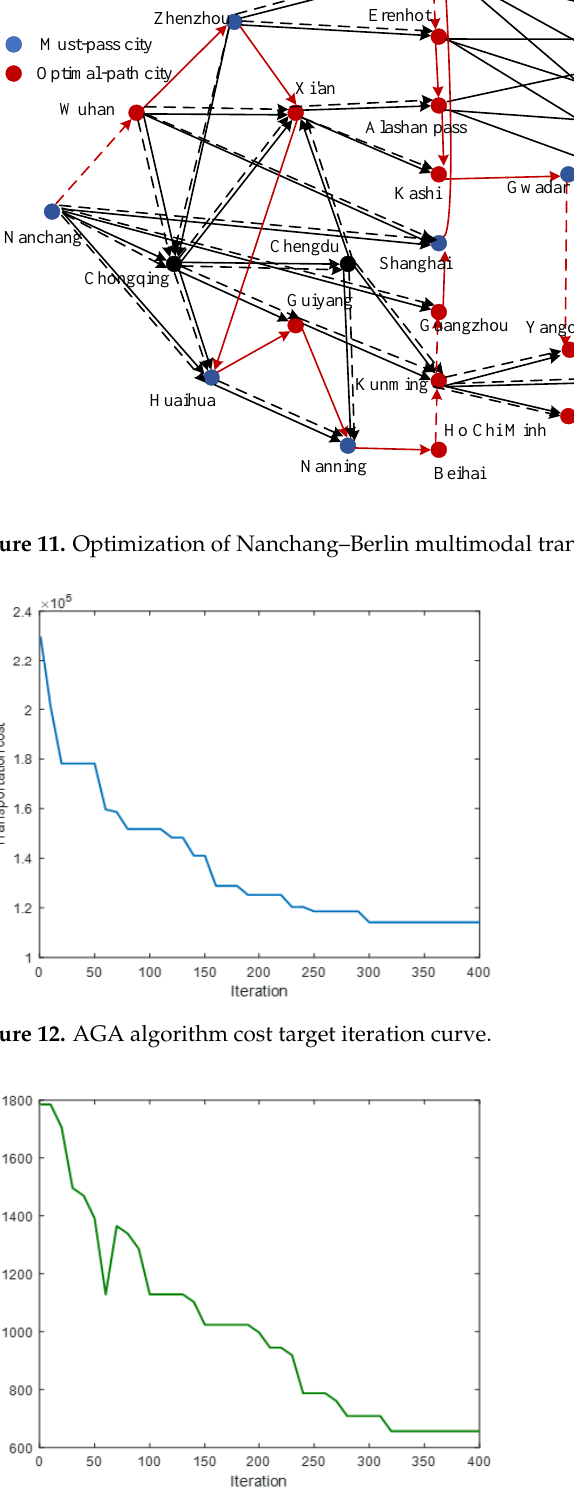
Figure 13. AGA algorithm time target iteration